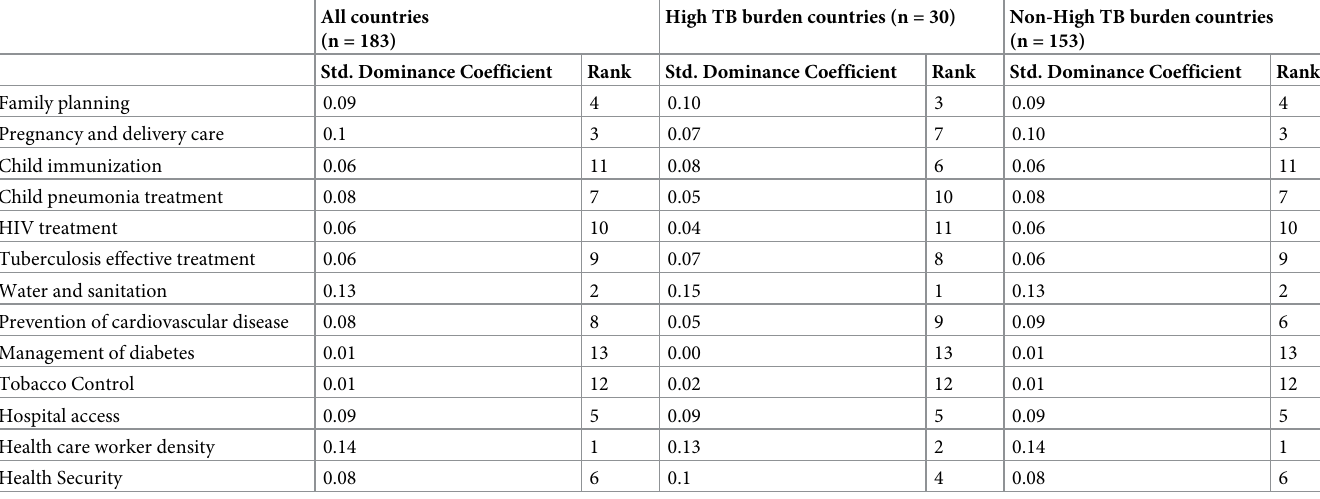
Table 3. Dominance analysis rankings service coverage indicators based as predictors of UHC SCI score, stratified by TB disease burden a,b . All countries (n =